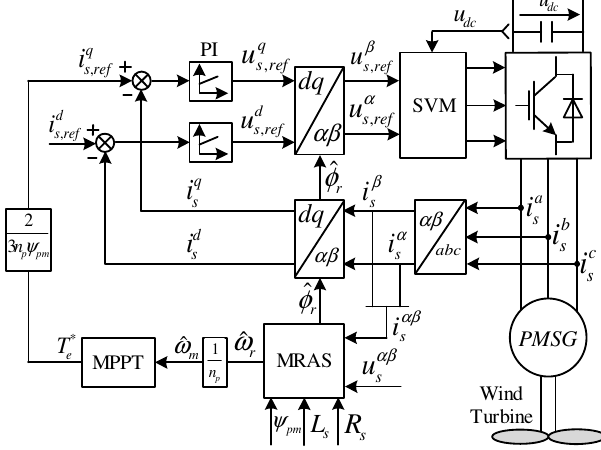
Figure 1. Encoderless field-oriented control for surface-mounted permanent-magnet synchronous generators (SMPMSGs) in variable-speed wind turbine